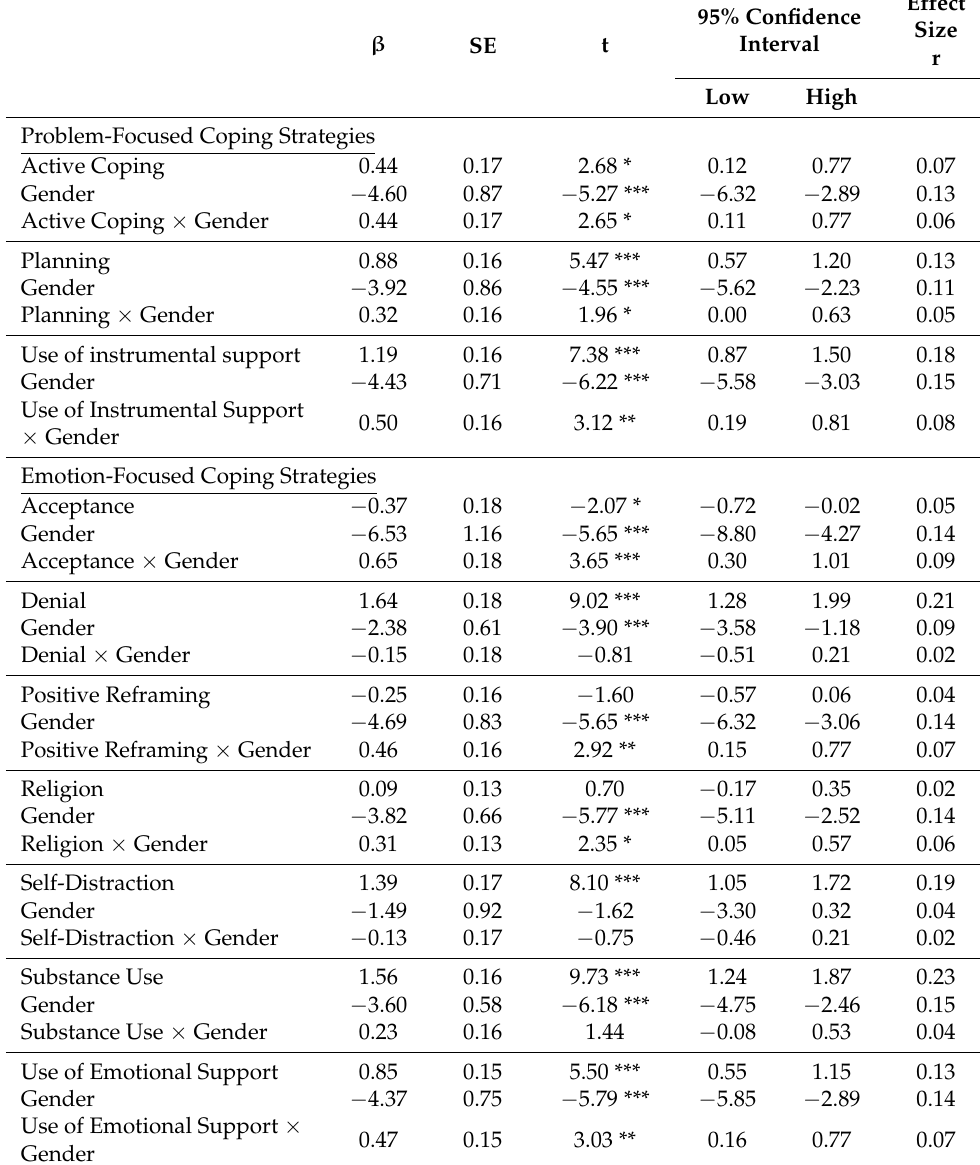
Table 3. Effects of Coping Strategies and Gender on PROMIS